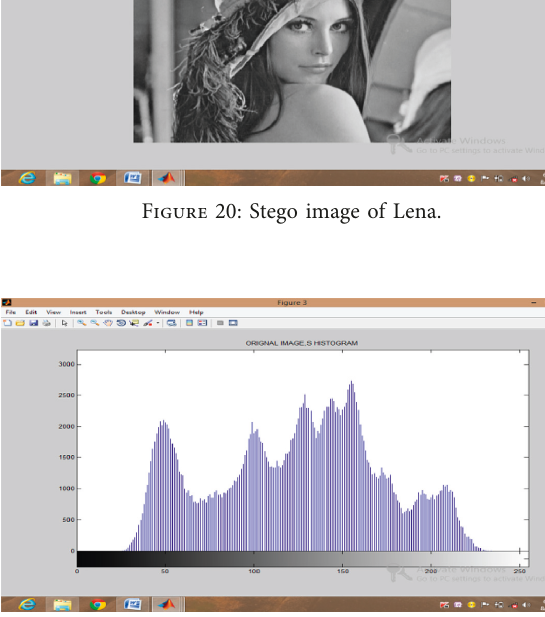
Figure 21: Histogram of original image of Lena.